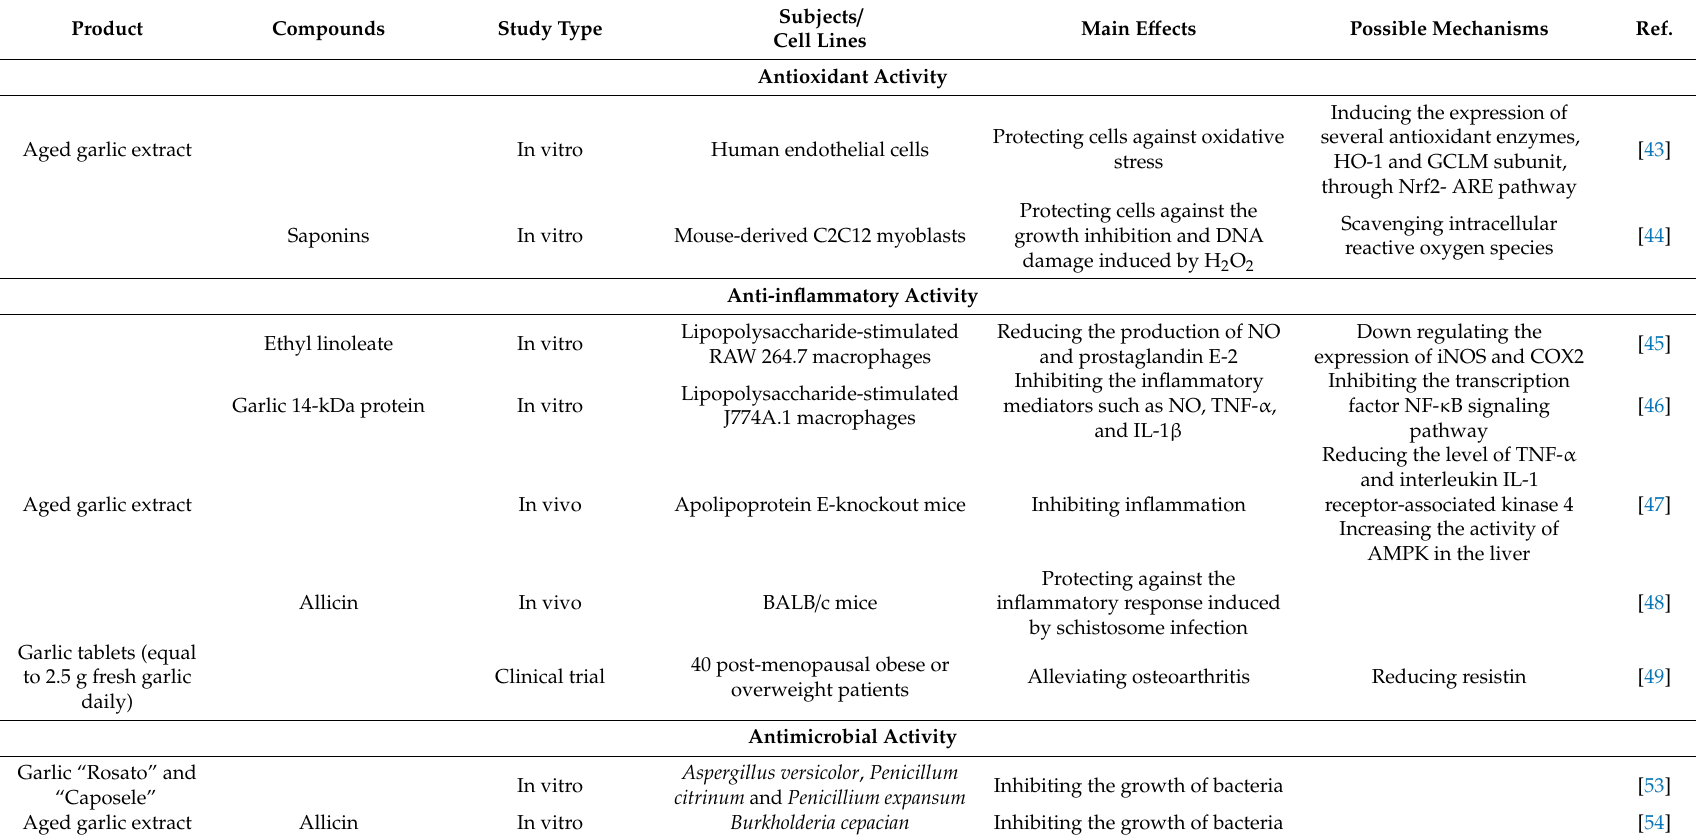
Table 1. The biological activities of garlic and its active